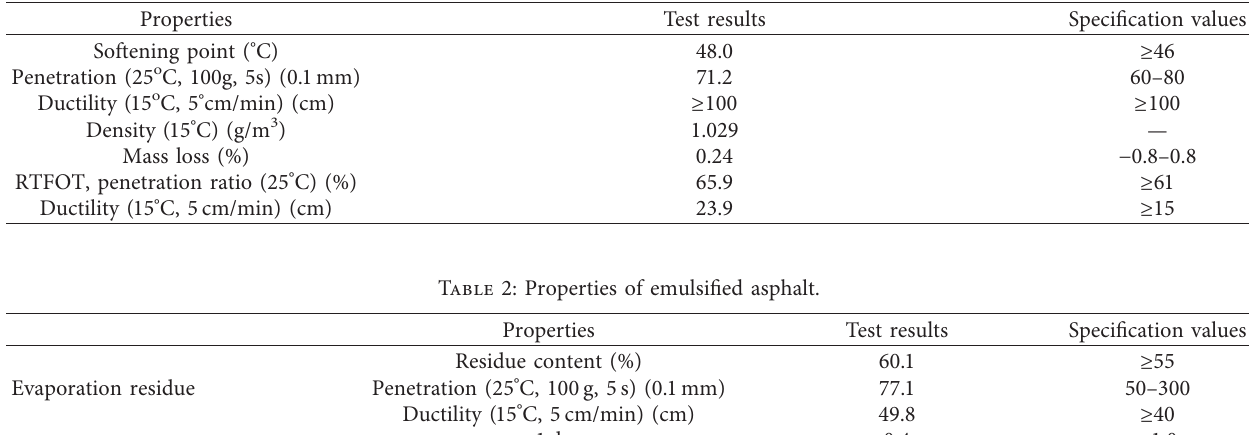
Table 1: Physical and chemical properties of original asphalt.